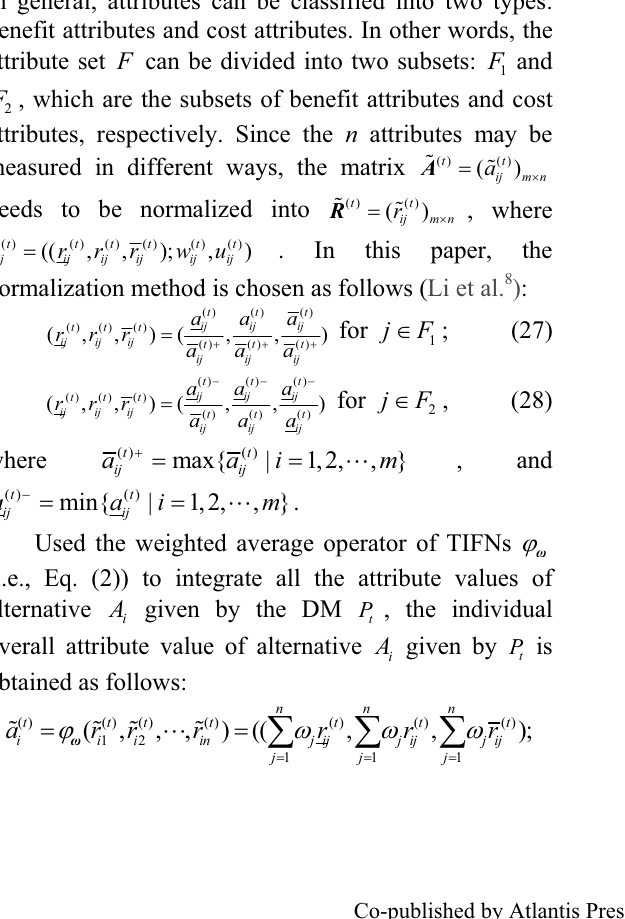
is the weight vector of the DMs, symbols respectively represent the max and min operators about variables t and j , which are denoted by By Definitions 9 and 12, and Eqs. (25) and (26), the possibility means, standard deviations and ranking indices of membership and non-membership functions for the collective overall attribute value of